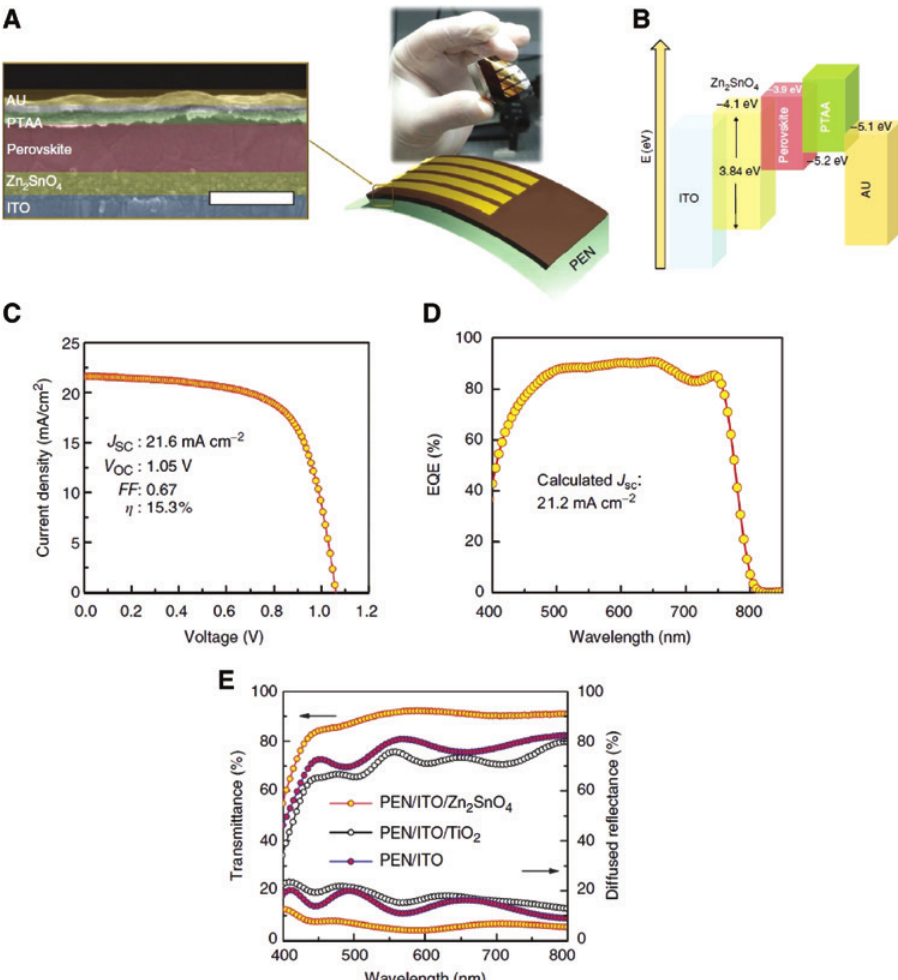
SnO nanocrystals as hole transporting layer. 2 4